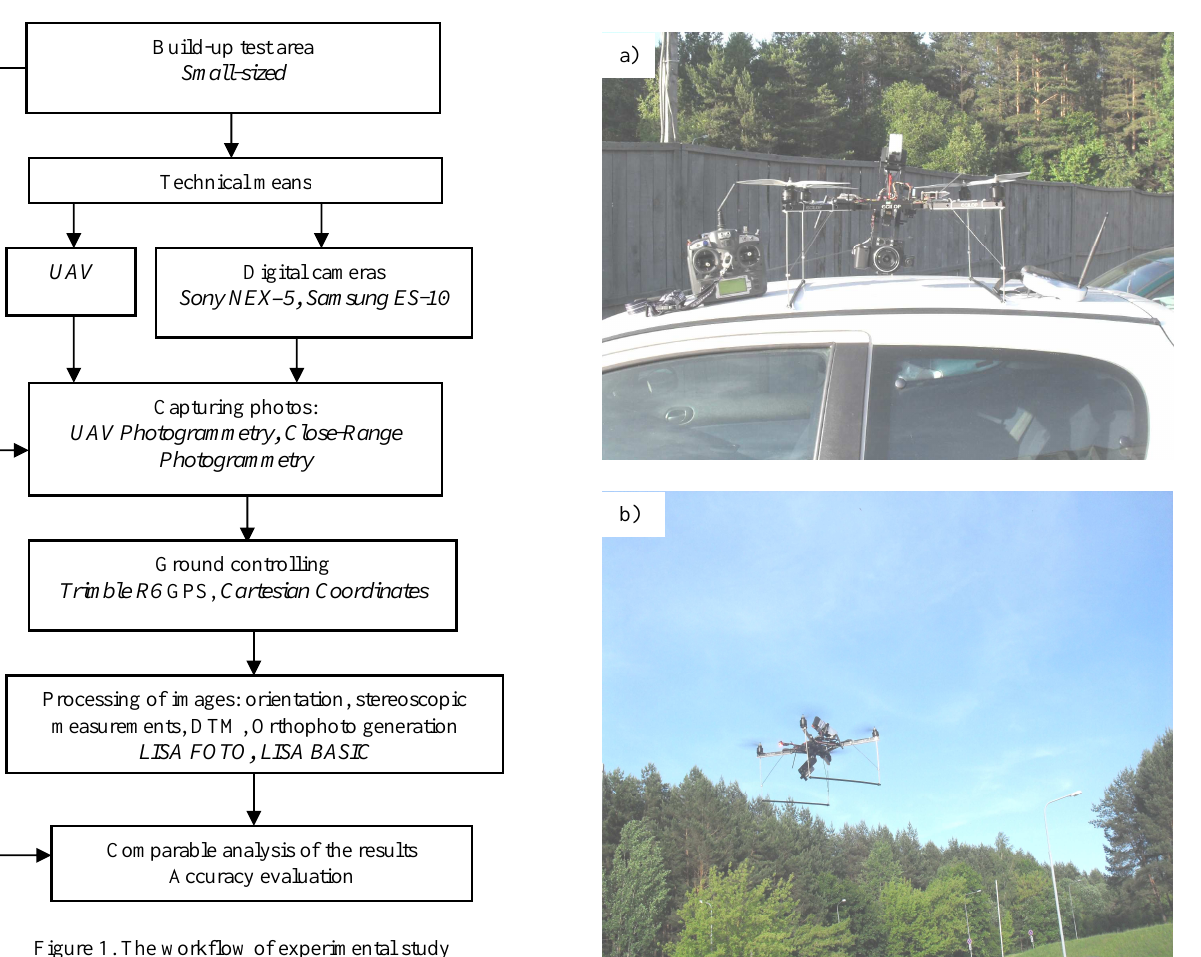
Figure 1. The workflow of experimental study